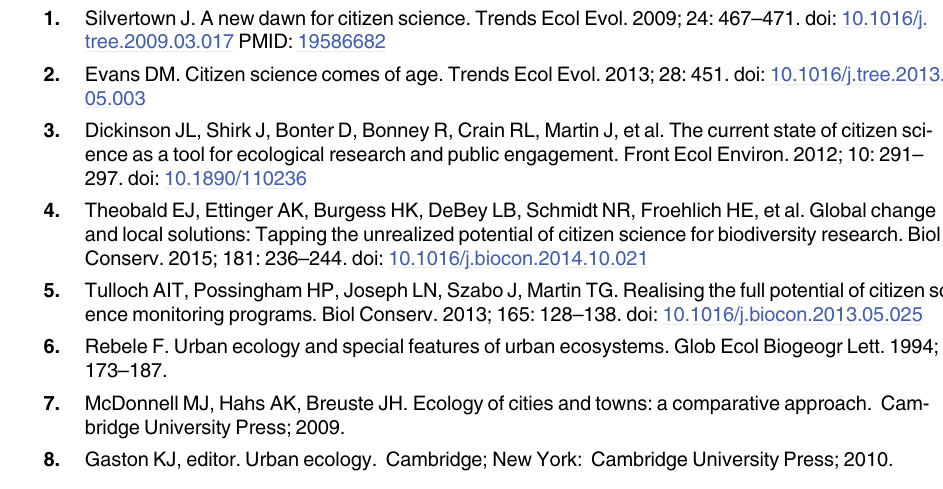
S3 Table. Citizen science and urban ecology metrics for birds. S4 Table. Citizen science and urban ecology metrics for butterflies. S5 Table. Full list of references and tags for birds. S6 Table. Full list of references and tags for butterflies.